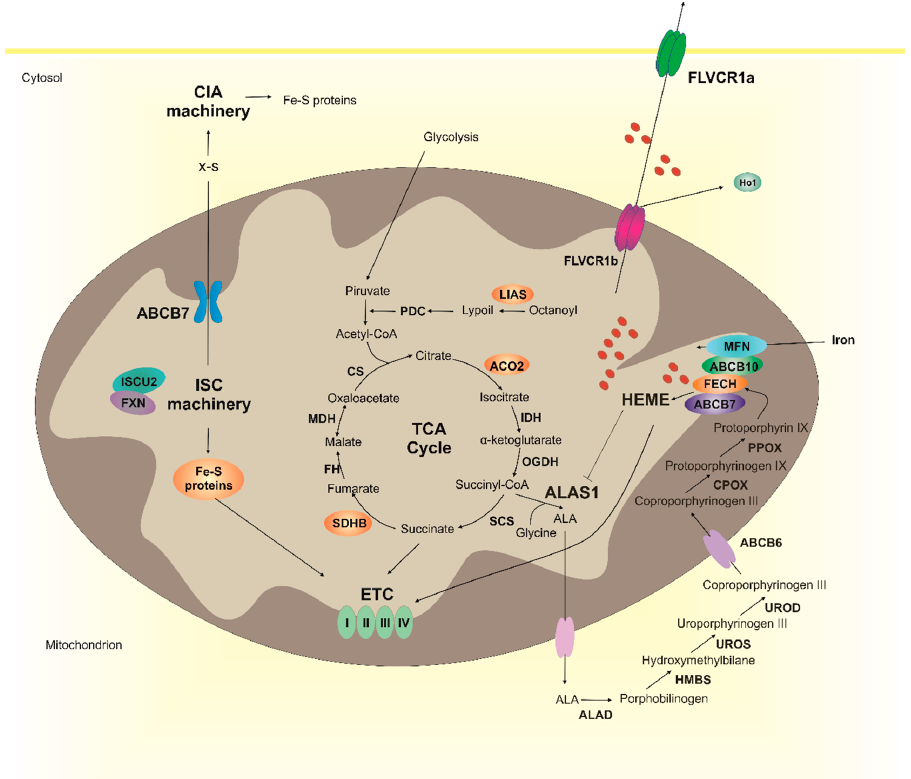
Figure 1. Heme metabolism and Fe-S cluster biogenesis are interconnected. The ISC machinery (composed by ISCU2, FXN, and other 16 proteins) is responsible for the generation of Fe-S clusters necessary for several mitochondrial proteins (in orange), including those of the electron transport chain (ETC), some enzymes of the TCA cycle (ACO2 and SDHB) and LIAS. The ISC machinery is also responsible for the generation of a X-S compound that is exported in the cytosol by ABCB7 and used by the CIA machinery for the generation of Fe-S clusters to be incorporated into non-mitochondrial proteins. Heme is synthesized through eight enzymatic reactions occurring between mitochondria and cytosol. The availability of free heme is further controlled at the level of heme catabolism (HO1) and heme export (FLVCR1a and FLVCR1b). FLVCR1b has been drawn on both mitochondrial membranes, however its specific subcellular localization still remains to be determined. Although not shown in the picture other heme importers and exporters have been identified (see the text for details). Both heme and Fe-S clusters are necessary for the ETC activity. Interestingly, the biosynthetic pathways of the two cofactors are strongly interconnected. Indeed, heme synthesis depends on Fe-S clusters for succinyl-CoA supply, for the expression of ALAS1 and FECH. Whether Fe-S clusters biogenesis depends on heme is less clear. The condensation of succinyl-CoA and glycine by ALAS represents the rate limiting step in heme biosynthesis and, in erythroid cells, it is dependent on Fe-S clusters levels. The cytosolic Fe-S cluster protein aconitase is a bifunctional enzyme and, following the loss of its Fe-S cluster (in iron deficiency), functions as an iron responsive protein (IRP) [64,65] inhibiting the translation of ALAS2